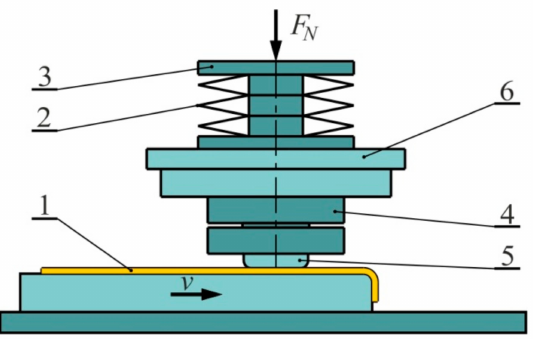
Figure 10. Schematic illustration of flat-die strip drawing: 1—specimen, 2—spring, 3—spring bu ff er, 4—tool holder, 5—tool, 6—force